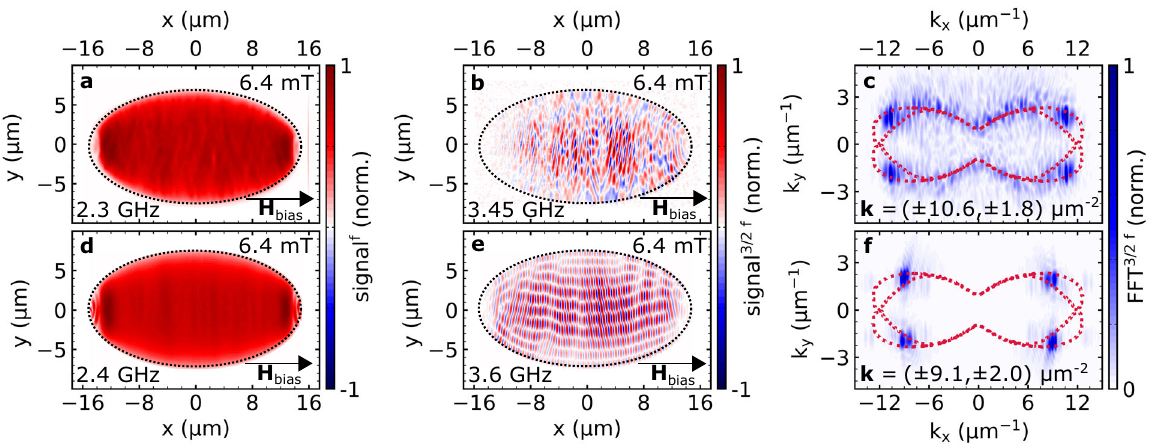
Fig. 4 | Spatially-resolved imaging of NLSWs and comparison to simulations. Spatially-resolved SNS-MOKEmeasurementsanalyzed atf rf and 3/2f rf are shownfor an elliptical element (30 μ m×15 μ m) in a and b , respectively. While a shows a uni- form signal across the entire structure the 3/2 f rf response in b appears completely differentandconsistsofacomplexspin-wavepattern.Byutilizinga2D-FFTthewave